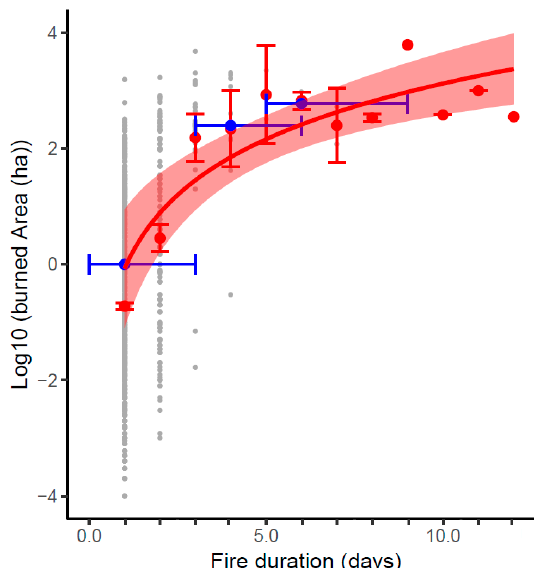
Figure 4. Relationship between fire size (Y-axis, Log10 scale in ha) and fire duration (X axis in days) over the 1985–2006 period in Tunisia (grey dots represent fire events and red dots the mean size for each duration with standard deviation intervals). The log10 regression fitted on mean values is also represented (Red line) with its 90% confidence interval (shaded red area). The duration of Sirocco events (in days) during fire size classes >1 ha, >100 ha and >400 ha is also represented (blue dots and 95% confidence interval bars).